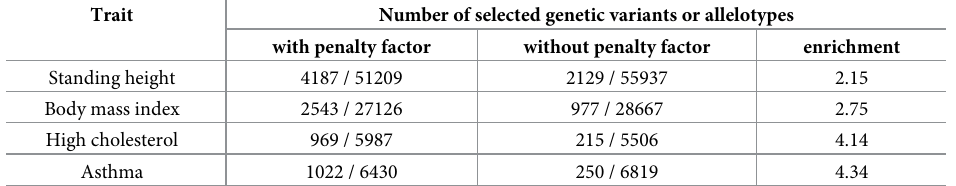
Table 1. The prioritization of the medically relevant alleles with penalty factors. The numbers of the genetic vari- ants or allelotypes with non-zero coefficient values are shown for the selected four traits. The denominator represents the total number of variables included in the model. The numerator represents the number of the medically relevant alleles, which are one of the following: protein-truncating variants, protein-altering variants, imputed HLA allelotypes, the pathogenic or likely-pathogenic variants in the ClinVar database. The enrichment of the medically relevant variants is also shown. Trait Number of selected genetic variants or